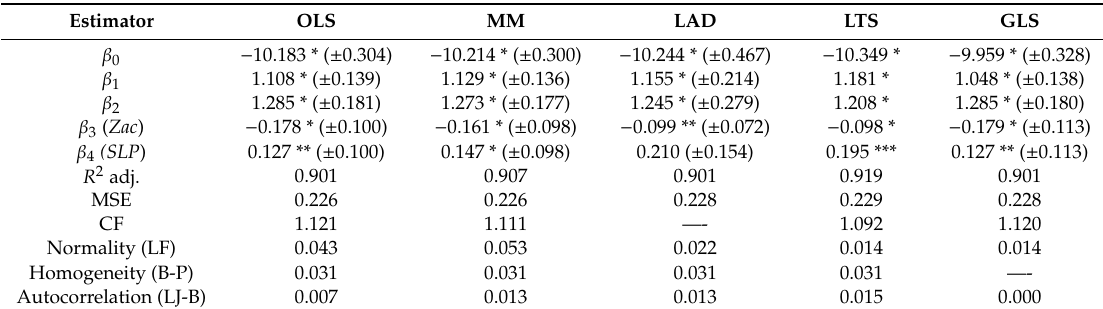
Table 4. Statistics of robust regression